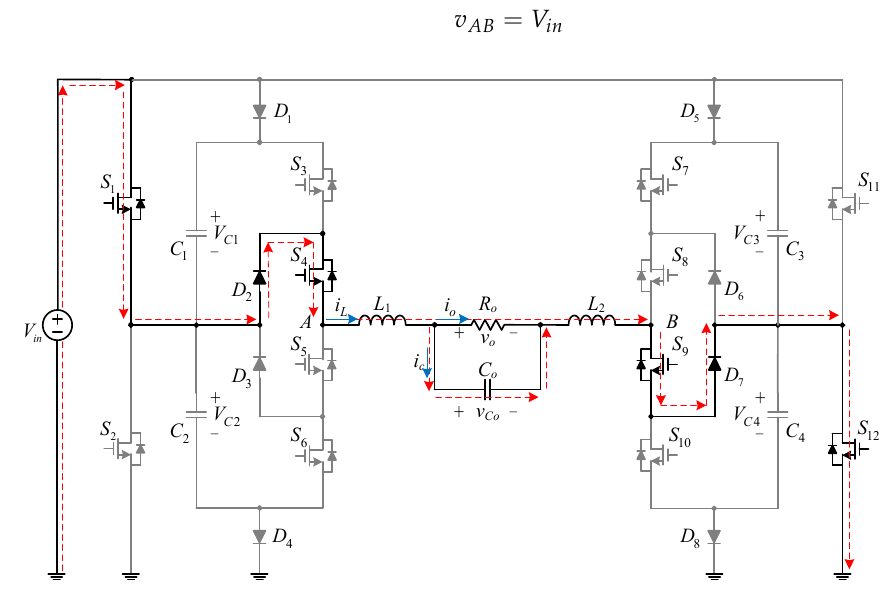
Figure 8. Current flow of stage II when switch S 3 is on. Interval [ t 4 ≤ t ≤ t 5 ] : The switches S 3 and S 10 are off, but the switch S 1 is on. As shown in Figure 9, the current flowing through the inductors L 1 and L 2 will form a circuit loop from the input voltage to the switches S 1 , S 4 , S 9 , S 12 and the diodes D 2 , D 7 ; therefore, the voltage across the terminals A and B is